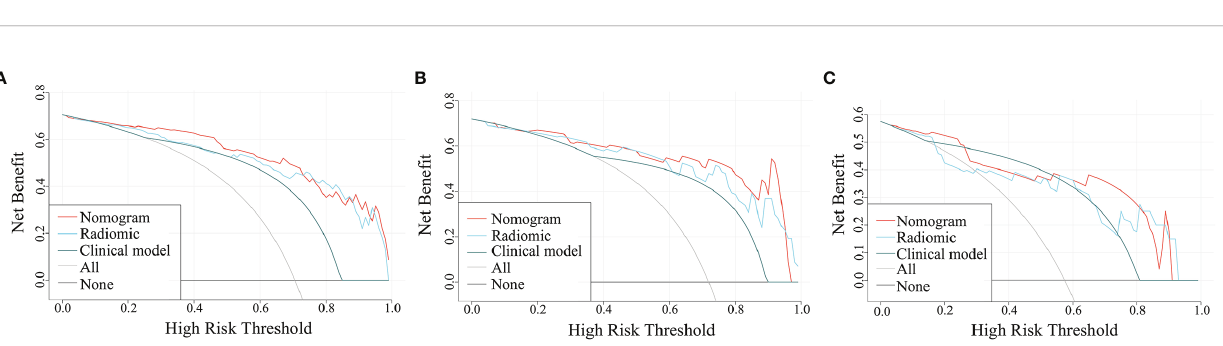
FIGURE 10 | Decision curves for the three models in the training (A) , testing (B) , and independent validation (C) cohort. The x- and y-axes of the curve represent the threshold probability and the net bene fi t,